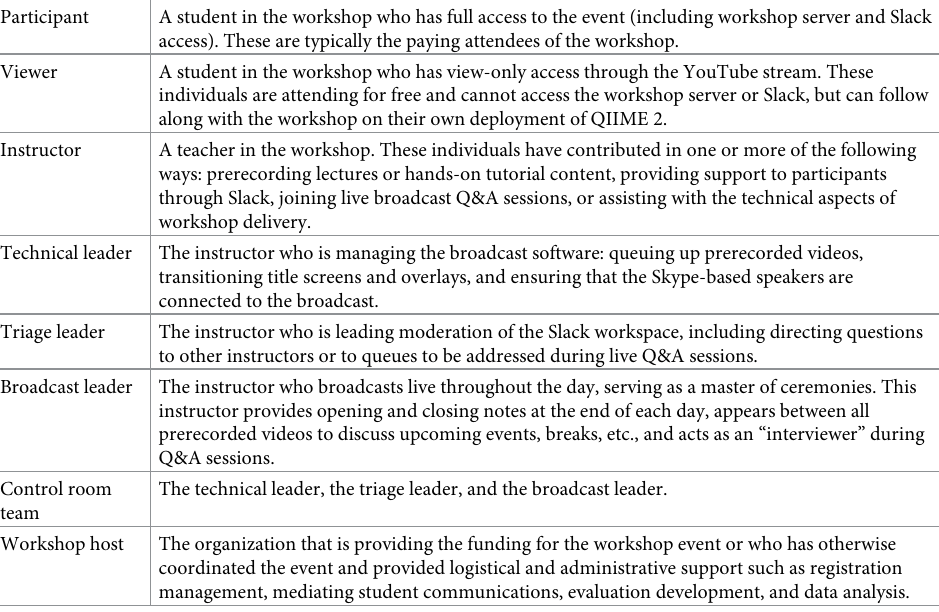
Table 1. Workshop Role and